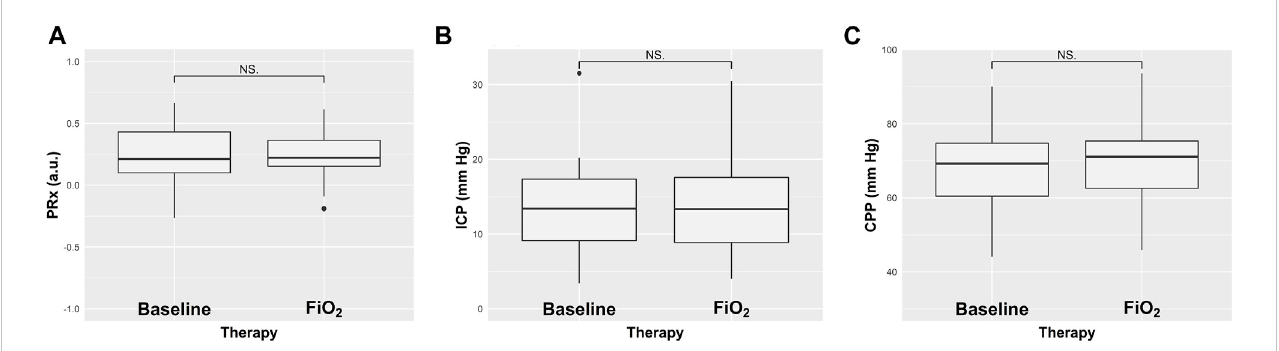
FIGURE 1 Boxplots representing the effect of increased fraction of inspired oxygen (FiO 2 ) on cerebral autoregulation measured with pressure reactivity test (PRx) (A) , intracranial pressure (ICP) (B) , and cerebral perfusion pressure (CPP) (C) from baseline. Values are presented as median and interquartile range.